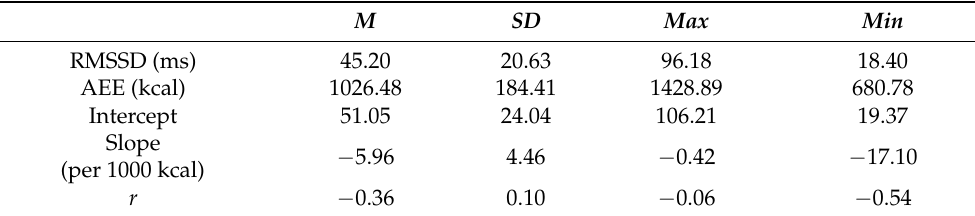
Table 2. AddHRVr algorithm calibration: Descriptive statistics of the individual parameters for all 38 firefighters calculated for 24 h of